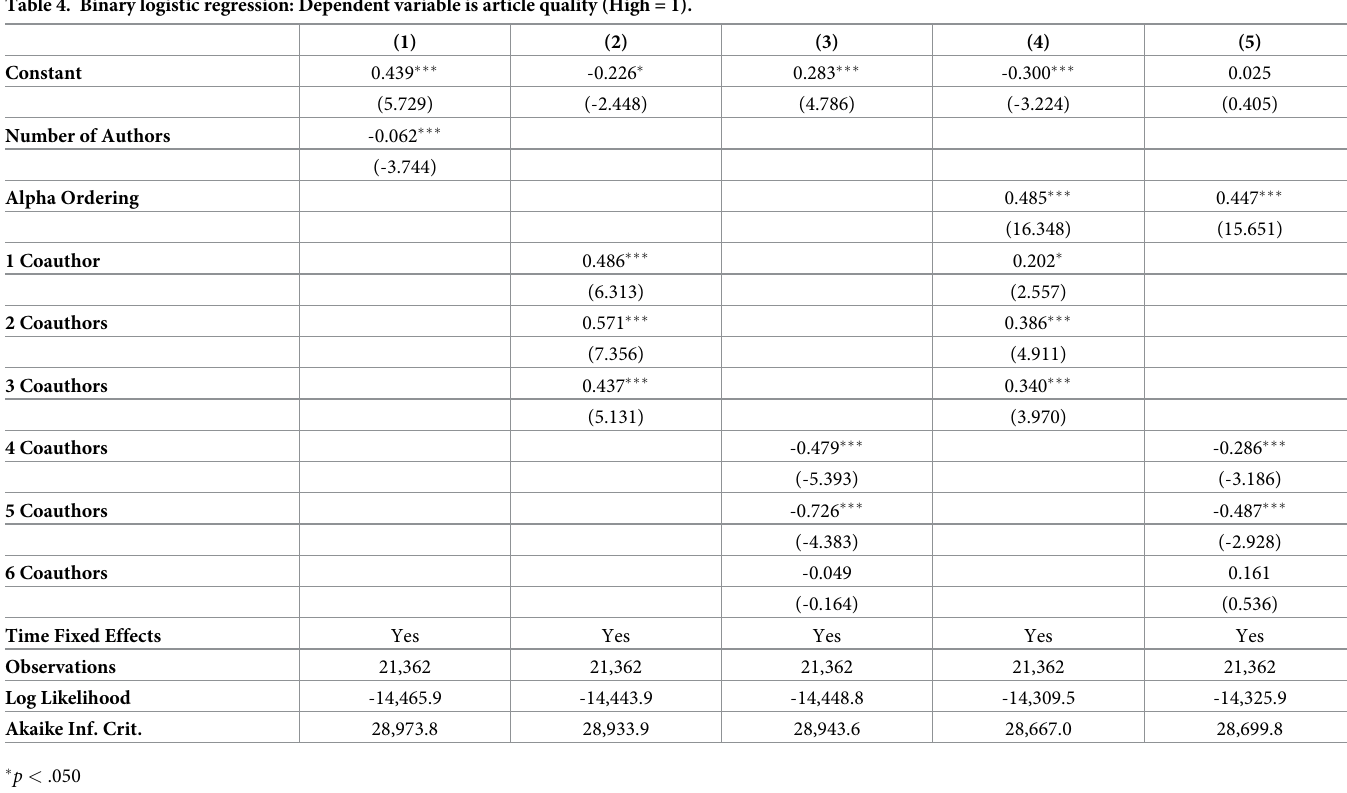
Table 4. Binary logistic regression: Dependent variable is article quality (High =